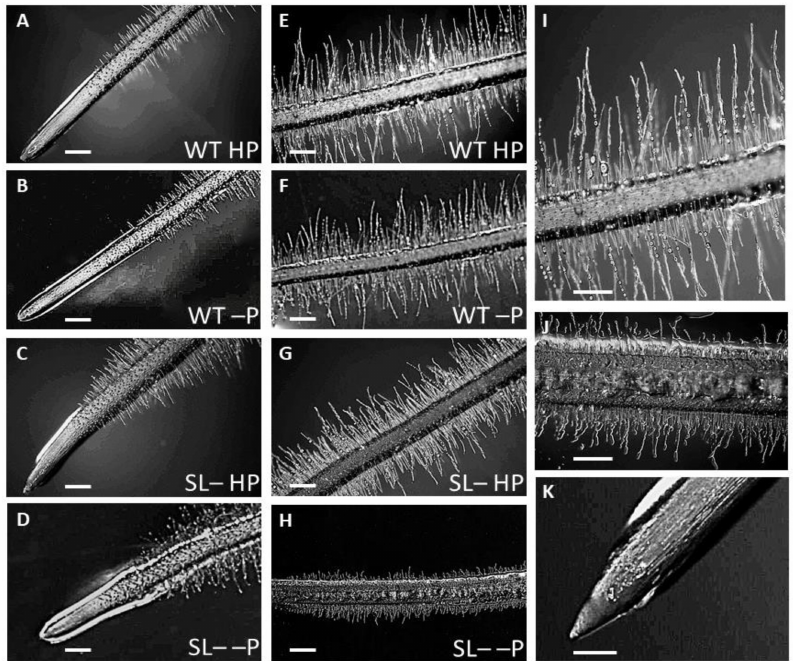
Figure 5. Root tip morphology of wild-type (WT) and strigolactone-depleted plants (SL–) grown for 10 days in MS medium with either high P or low P and further transferred for one week to MS medium containing either high P (HP) or no P (–P), respectively. ( A – D ) Root primary morphology, di ff erentiation zone and tip of plants: ( A ) WT under HP ( B ) WT under –P ( C ) SL– under HP ( D ) SL– under